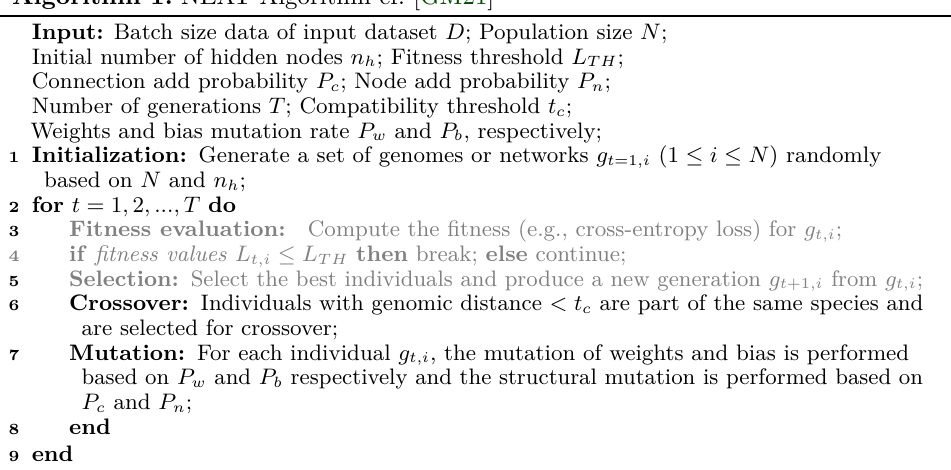
Algorithm 1: NEAT Algorithm cf.